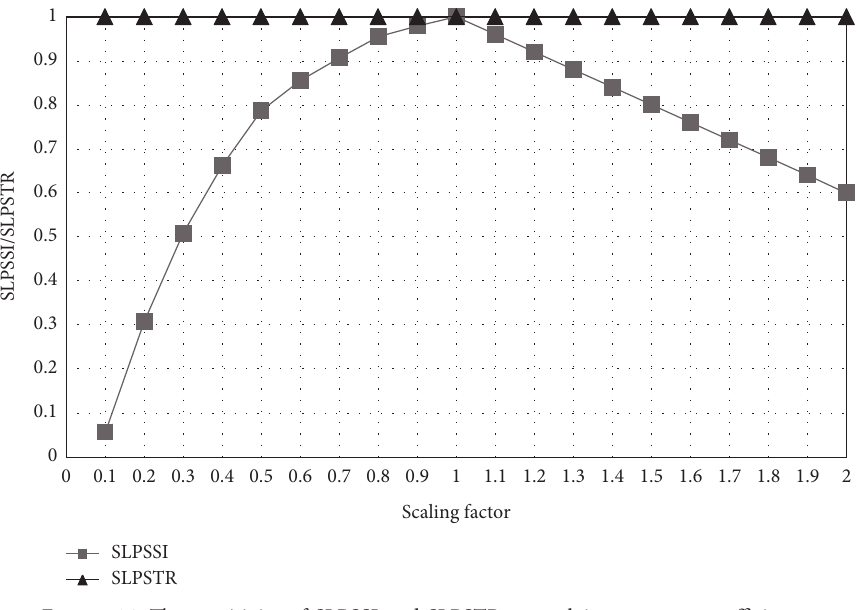
Figure 14: The sensitivity of SLPSSI and SLPSTR to applying constant